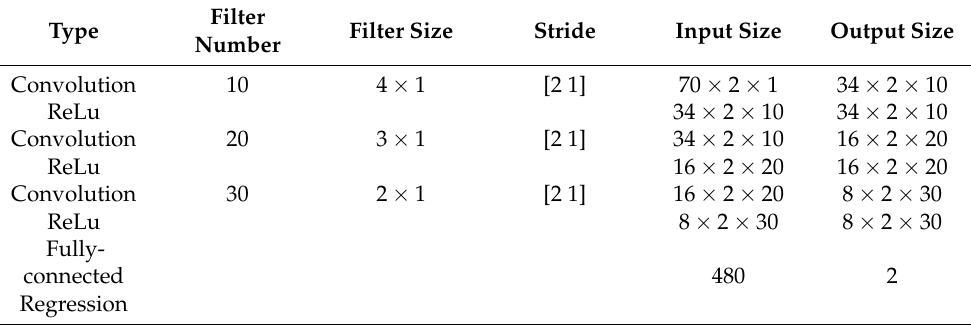
Table 1. ConvNet